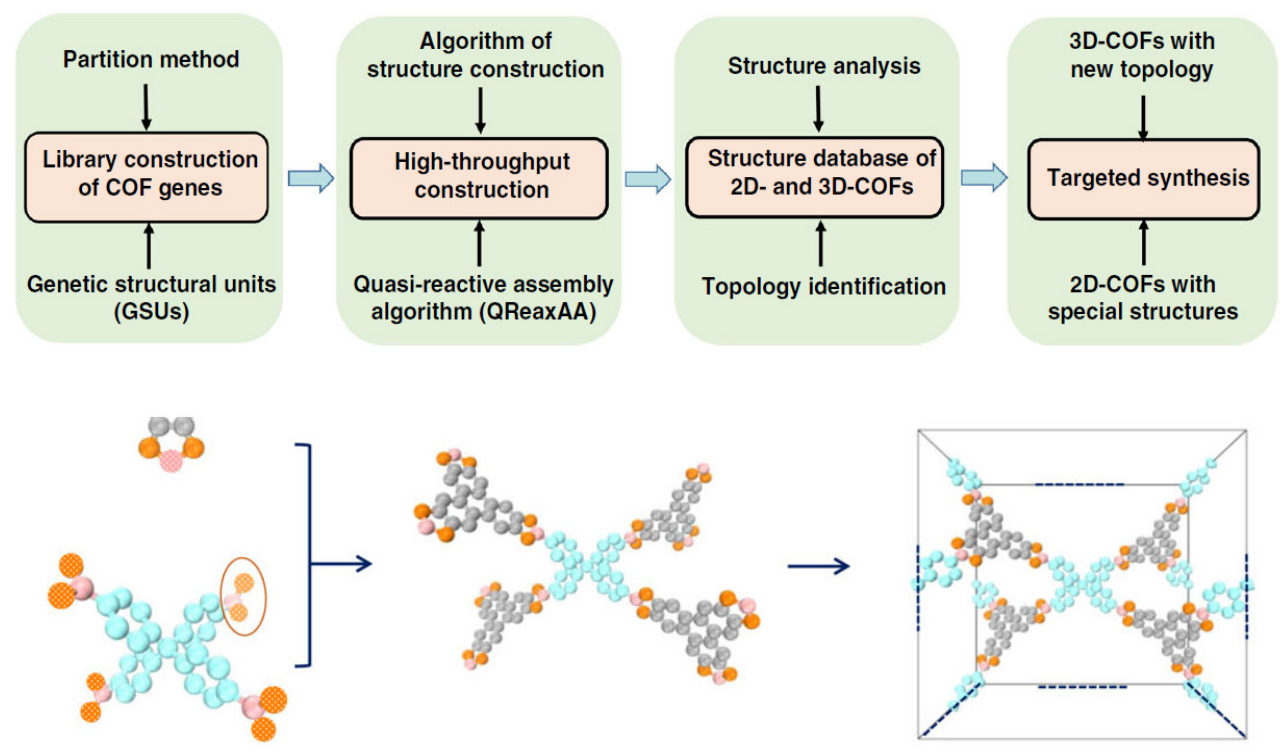
Figure 7. Schematic representation of the materials genomic method [40].